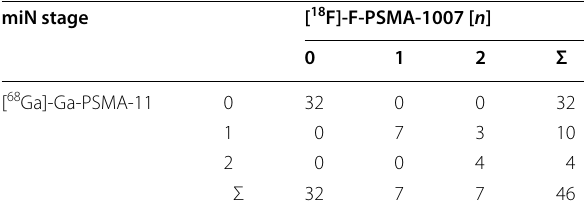
Table 5 miN stage by